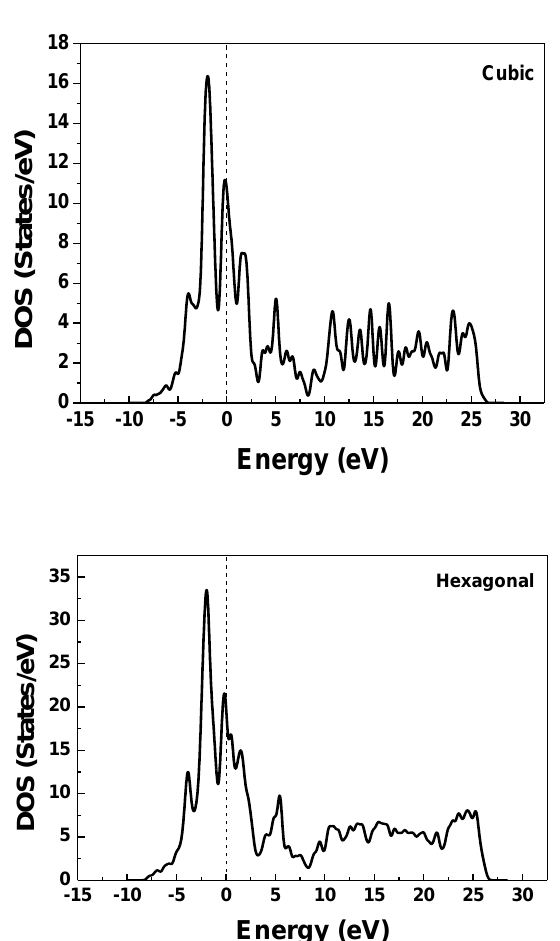
Fig. 6. The total electronic density of state for Fe 2 Hf in cubic and hexagonal